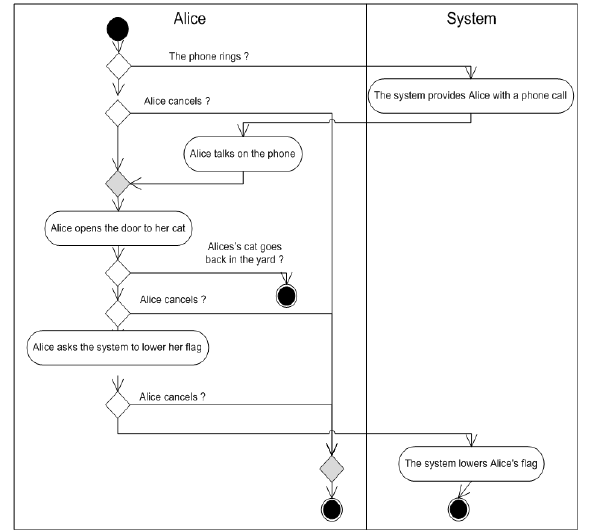
Figure 7. The generated activity diagram for “ Alice’s Cat goes home ” use case